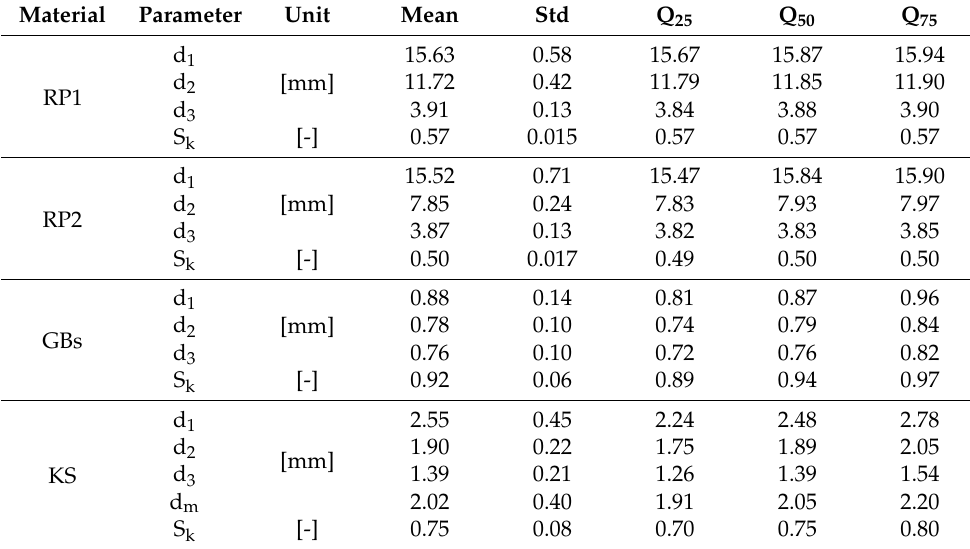
Table 1. Statistical analysis results of ellipsoid